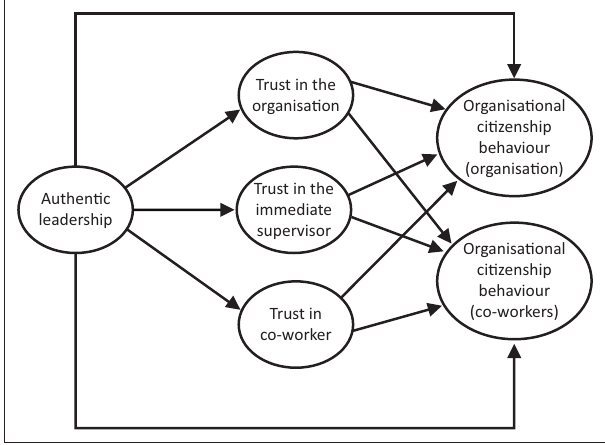
FIGURE 1: A hypothesised model of authentic leadership and organisational citizenship behaviour with the indirect effects of workplace trust.